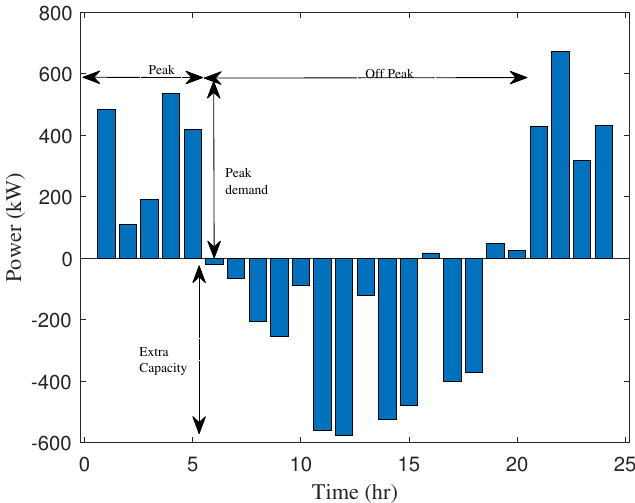
Figure 6. Demand − response schedule with actual PV and wind data.